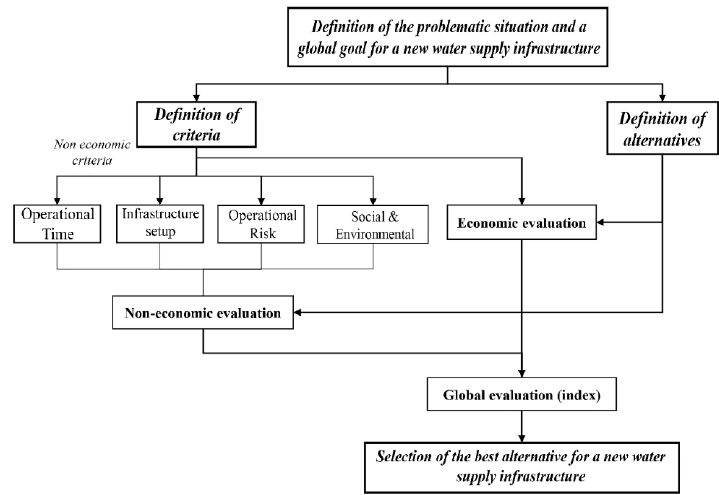
Figure 2. Methodology summary.